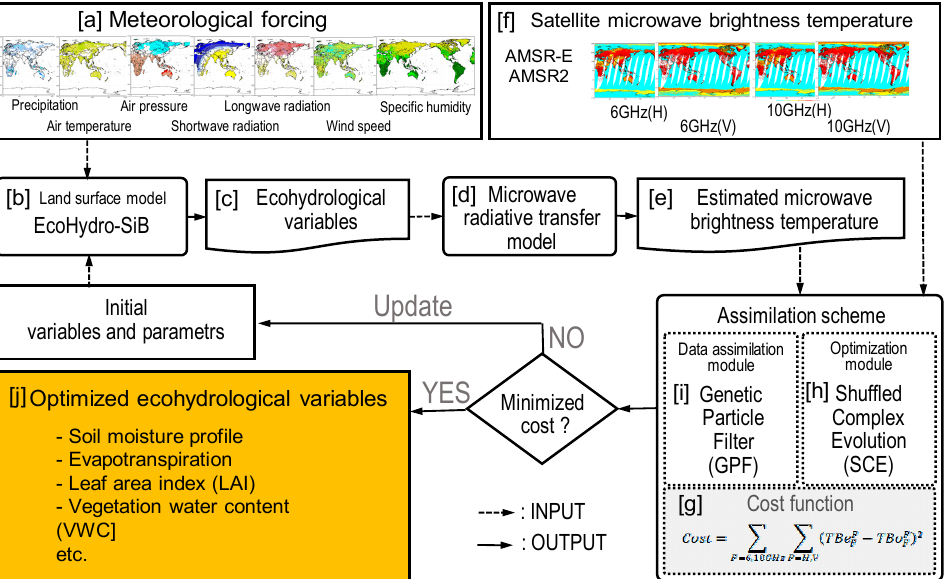
Figure 2. CLVDAS framework used in this study. Optimized ecohydrological variables are outputted from this system, and the near-surface soil moisture content, root-zone soil moisture content, and the vegetation water content, as optimized ecohydrological variables, are analyzed. The meteorological forcing dataset comprises precipitation (mm/s), air temperature (K), air pressure (mbar), shortwave radiation (W/m 2 ), longwave radiation (W/m 2 ), wind speed (m/s), and specific humidity (kg/kg). Satellite-observed brightness temperature dataset comprises brightness temperatures for 6.925 GHz horizontal polarization (6 GHz(H)), 6.925 GHz vertical polarization (6 GHz(V)), 10.7 GHz horizontal polarization (10 GHz(H)), and 10.7 GHz vertical polarization (10 GHz(V)). Meteorological forcing data ( a ) are input to EcoHydro-SiB ( b ). EcoHydro-SiB is a land surface model that calculates various ecohydrological variables ( c ). The calculated ecohydrological variables ( c ) are used to drive a